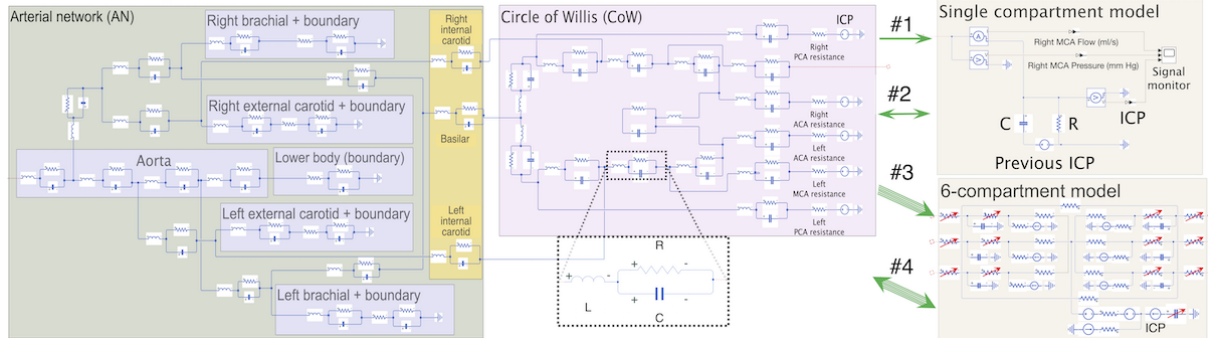
Figure 2. Diagram of model configurations 1–4. Schematic view of the various model configurations where green and pink boxes identify the AN and Circle of Willis vascular components, respectively, and intracranial models at right. Purple and orange boxes in the AN identify represented anatomy for reference. The vascular component is structured as in the source studies but uses 3-element electrical representations of each vessel, shown in the dashed white box. The single-compartment intracranial model is shown in the upper tan box; below it is a conceptual illustration of the 6-compartment model where red arrows indicate variable state components related to autoregulation and adaptive capacity. Unidirectional and bidirectional green arrows indicate the type of coupling between vascular and intracranial model components to distinguish configurations #1-4. ACA: anterior